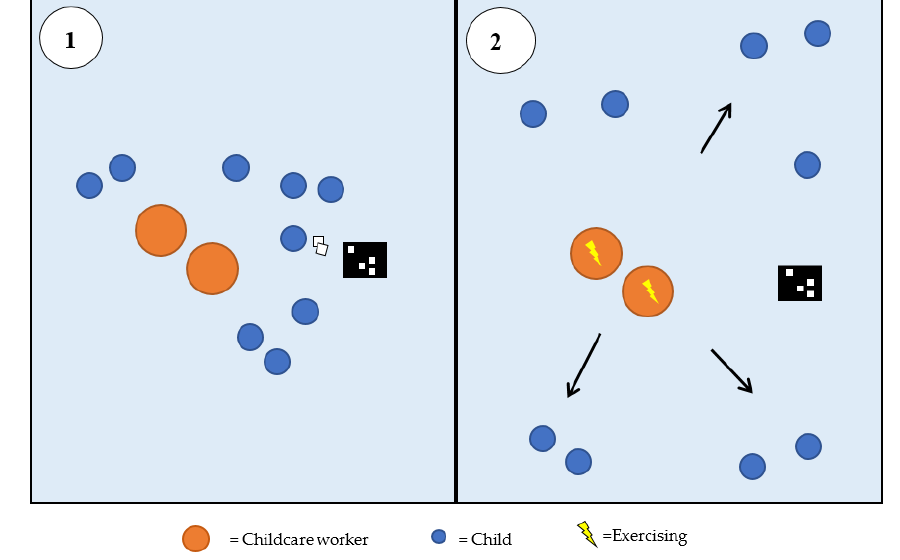
Figure A1. The Egg hunt. Further details in the Figure B1. The Egg hunt. Further details in the text